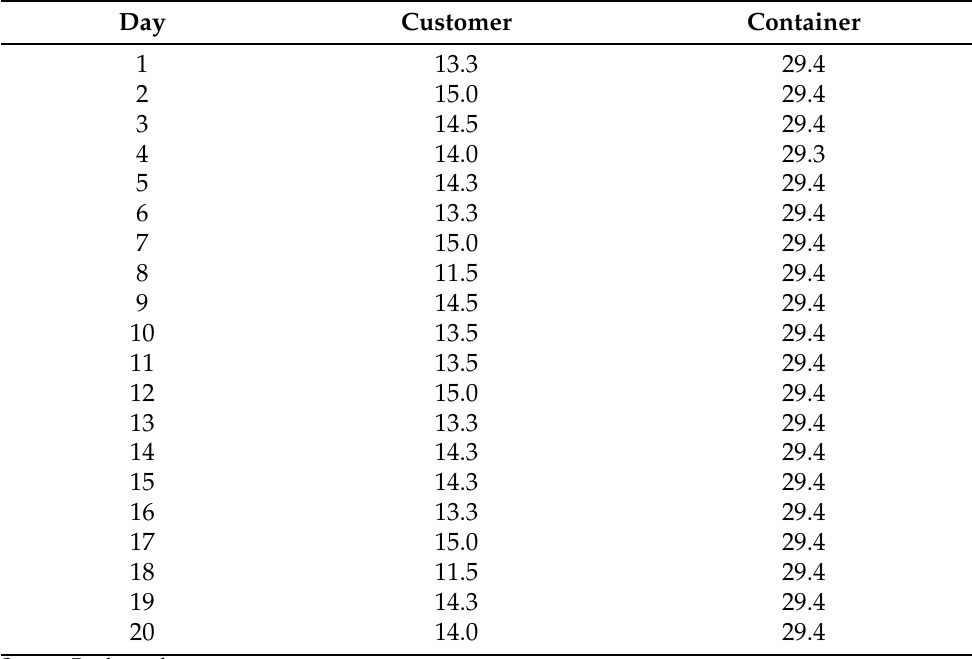
Table 7. Average results of customers and containers delivered each day—Instance Biobio.